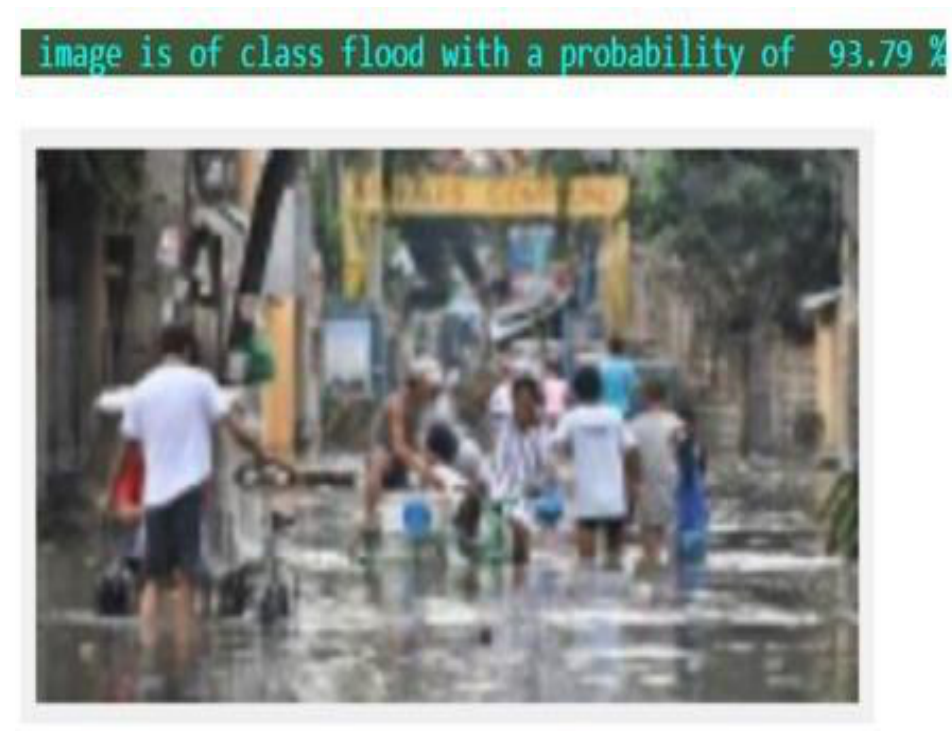
Fig. 6. Disaster detection using Social Media